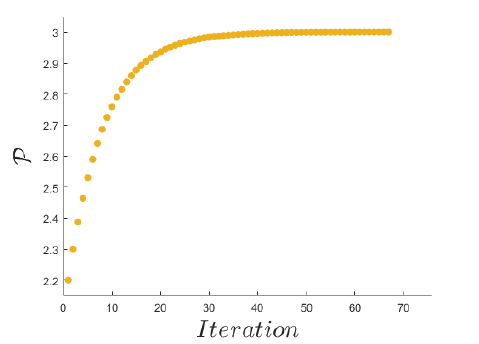
Figure 8. The proliferation rate P in terms of algorithm